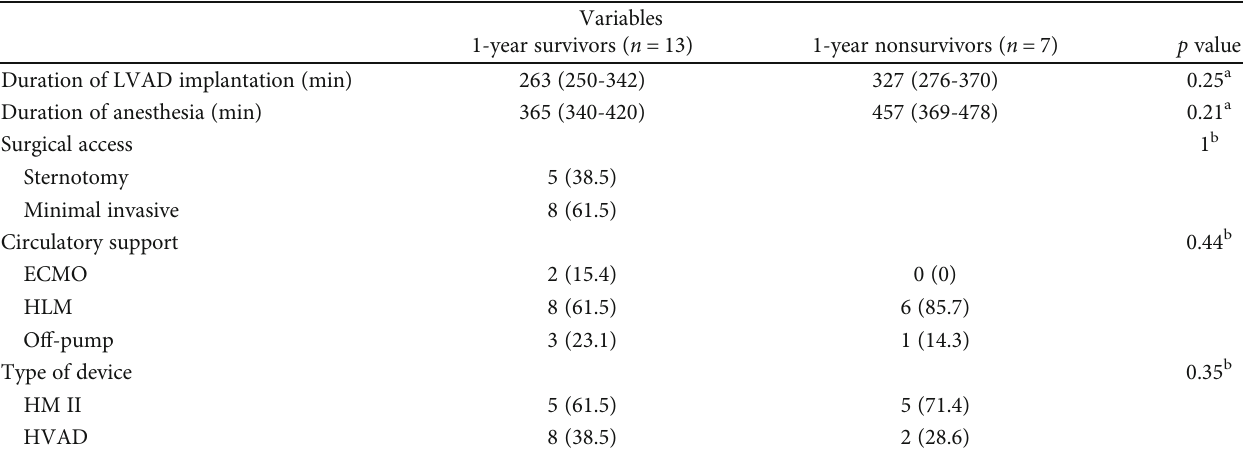
Figure 1: Patient fl ow chart. VAD =ventricular assist device; BIVAD=biventricular assist device; EXCOR®, Berlin Heart® GmbH, Berlin Germany; HeartMate II, Thoratec® Corporation, Pleasanton, CA; HeartWare® (HVAD), HeartWare International, Inc., Framingham, MA. Table 2: Procedural data ( n = 20